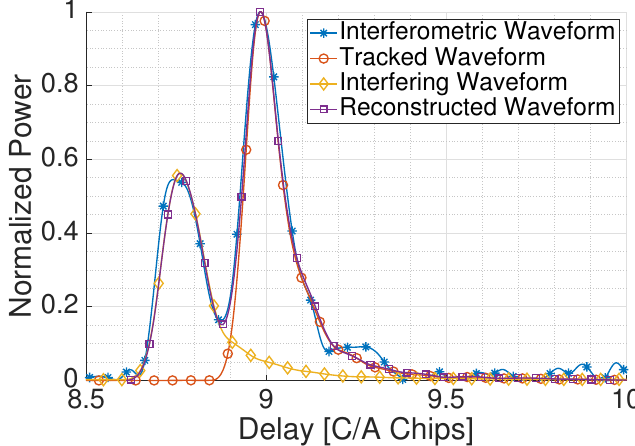
Figure 3. Retrieved L5/E5a interferometric global navigation satellite system-reflectometry (iGNSS-R) waveform (blue), Galileo E5a tracked conventional global navigation satellite system-reflectometry (cGNSS-R) waveform (red), global positioning system (GPS) L5 interfering cGNSS-R waveform (yellow), and reconstructed contaminated waveform (purple). The data was collected during the flight over the Bass